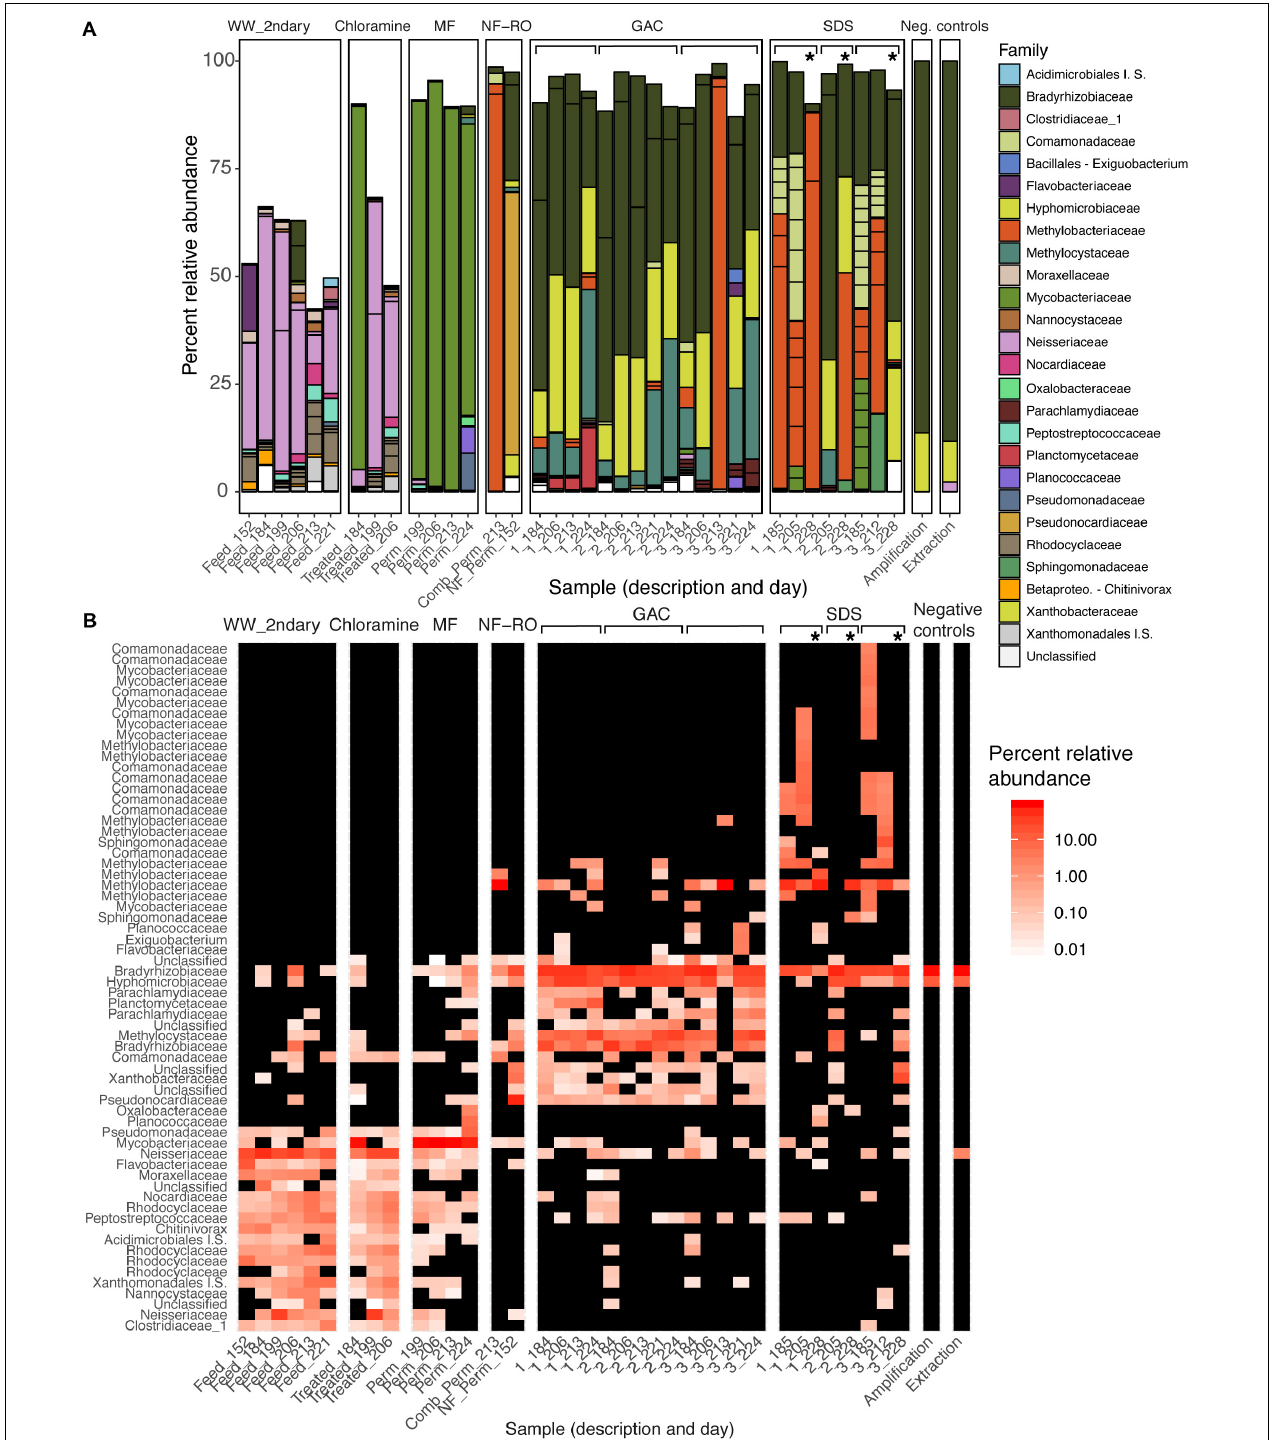
FIGURE 3 | Changes in the bacterial composition of bulk water through advanced treatment and simulated distribution. (A) Barplot and (B) heatmap of amplicon data across the treatment train. (A) Samples are bars grouped by location in the treatment train. Bar height indicates relative abundances and Family-level taxonomy of ASVs, and each segment within a bar represents a unique ASV and is colored by Family (I.S., “Incertae Sedis”). (B) Samples are columns and ASVs are rows. Color indicates percent relative abundance on a log-scale (black indicates non-detection). Both panels report the same 64 ASVs present at a minimum relative abundance of 2% in at least one sample (see Supplementary Table S6 for additional data). Sample descriptions ( x -axis) indicate secondary wastewater entering